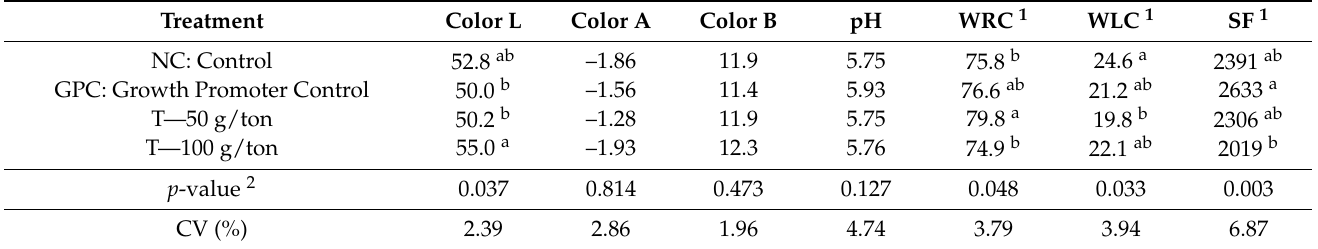
Table 8. Chemical-physical variables in the meat of broilers fed an antimicrobial blend to replace growth